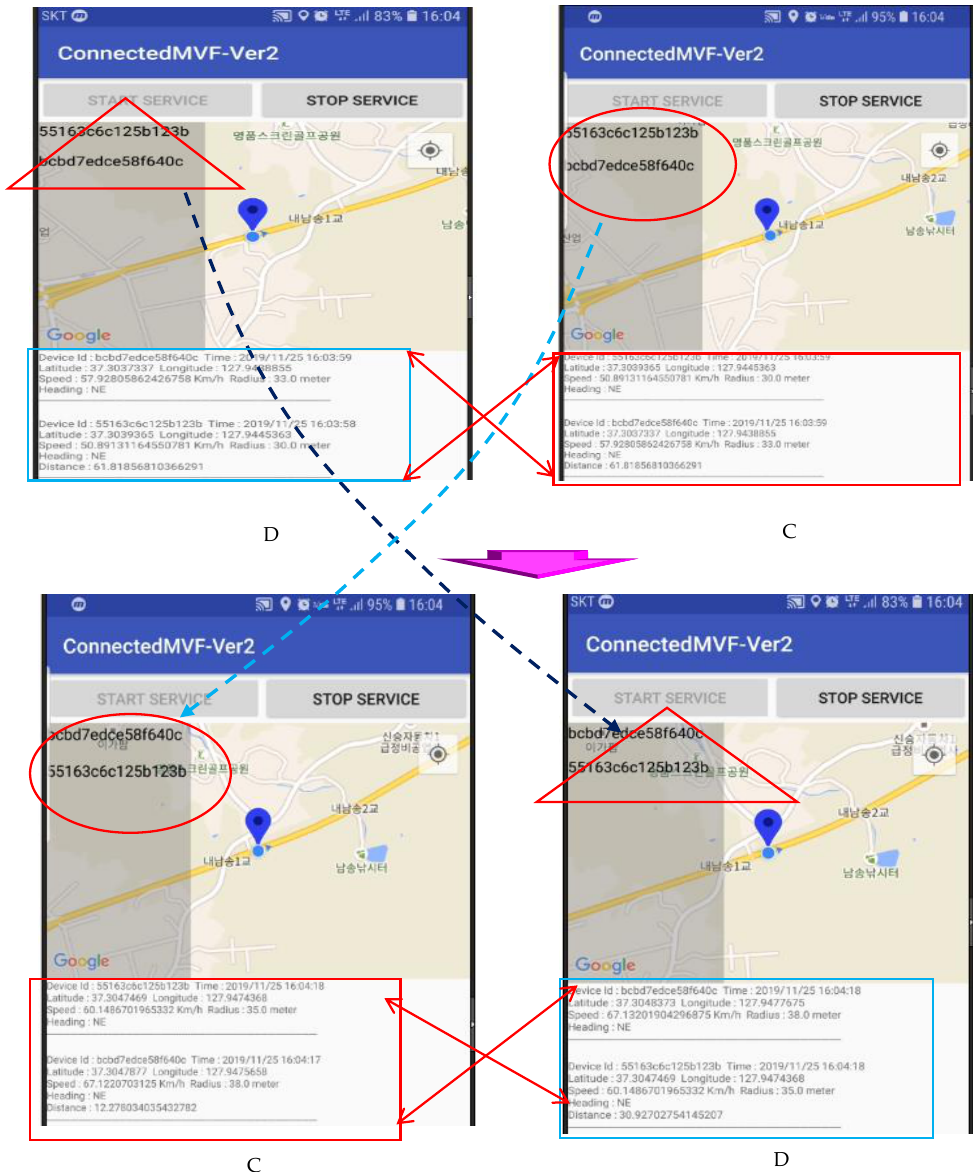
Figure 7. Screen images of when a connected group is formed (top) and when overtaking occurs (down).